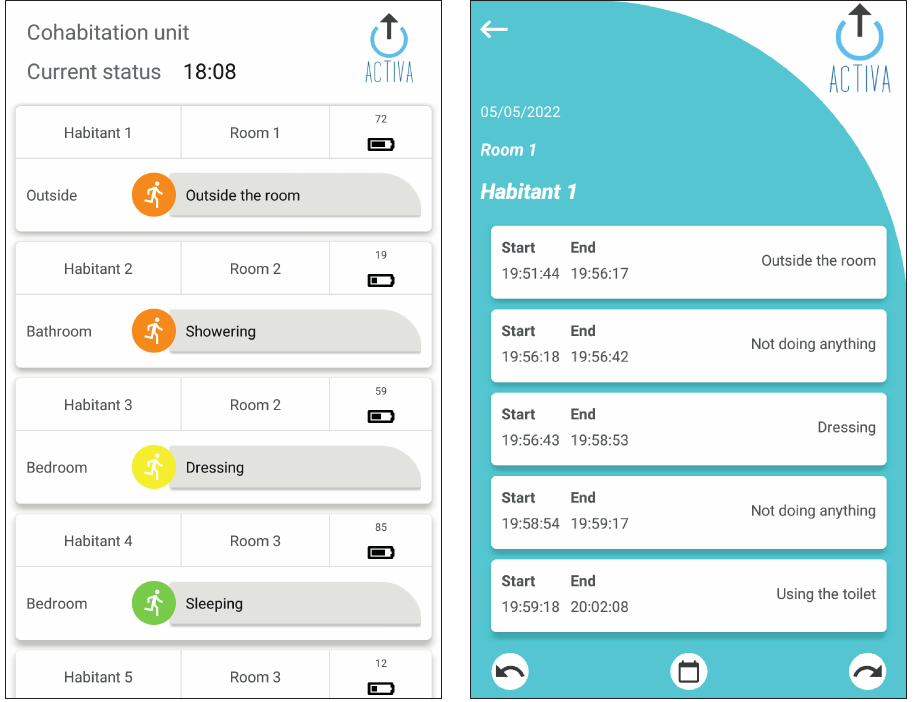
Figure 4. ACTIVA mobile application. The left image shows the inhabitants list view and the right image shows the list of historical activities of an